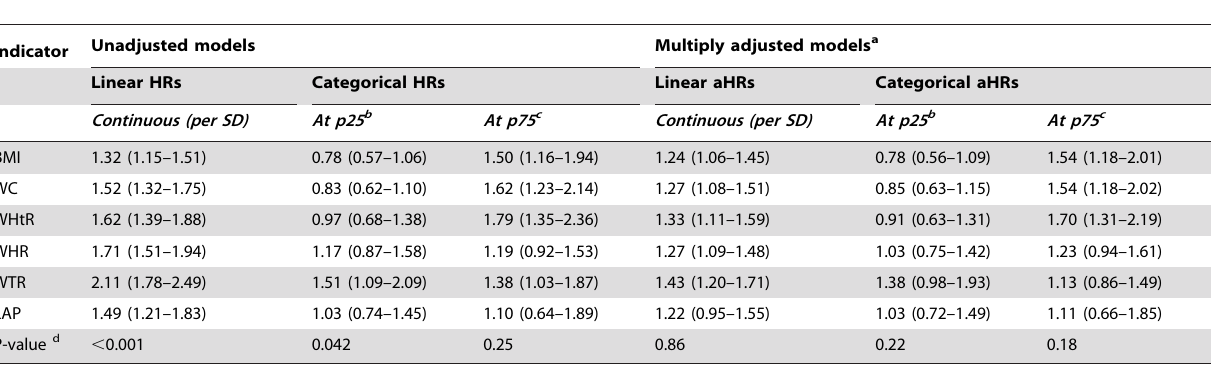
(Figure 2; p =0.07 for interaction). By contrast, black women 3.5]) (Figure 2). Table 3. Hazard ratios (95% CI) for all-cause mortality associated with 6 adiposity indicators presented as linear continuous models and categorical models at boundaries p25 or p75 for US nonelderly